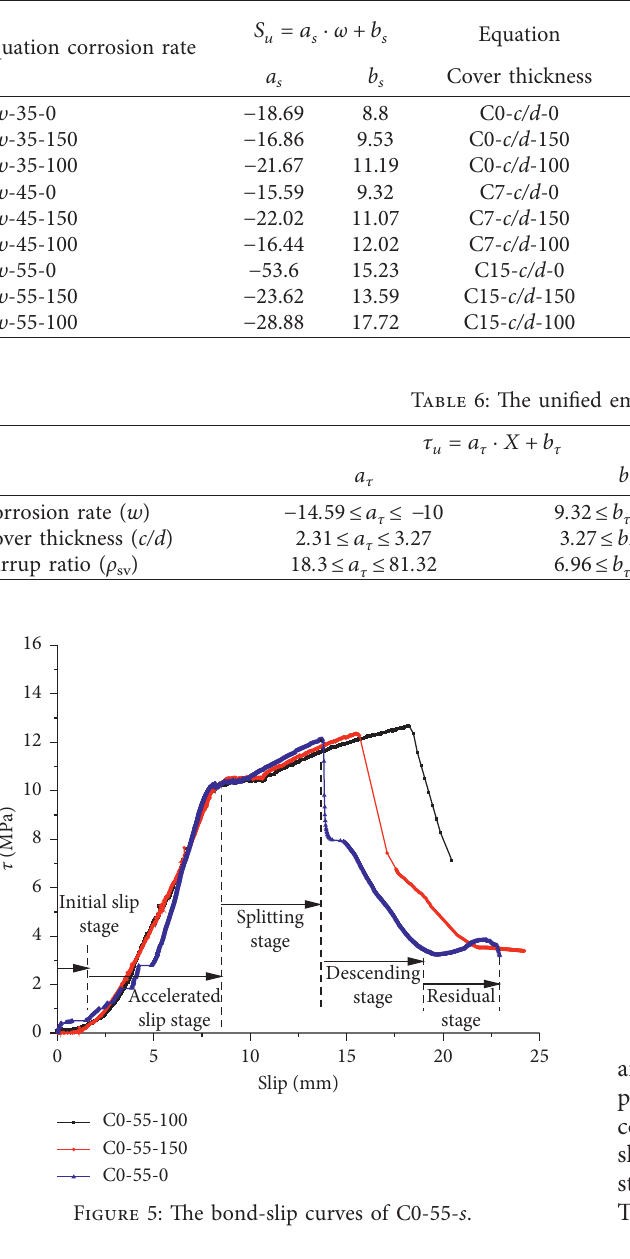
Table 5: The expression of the ultimate slip and the corresponding parameter.